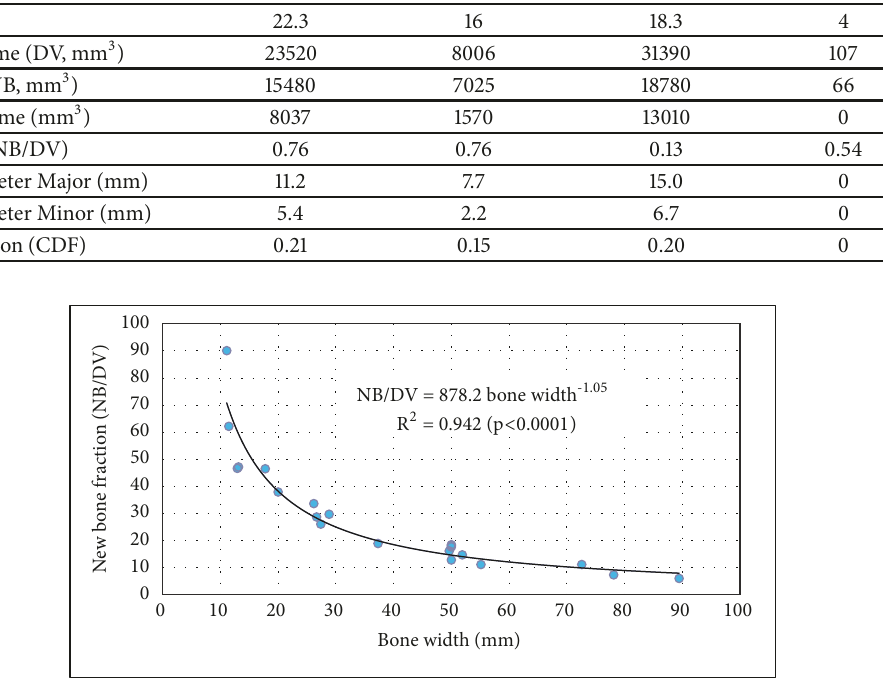
Figure 4: Initial defect volume (cc) as a function of bone width.